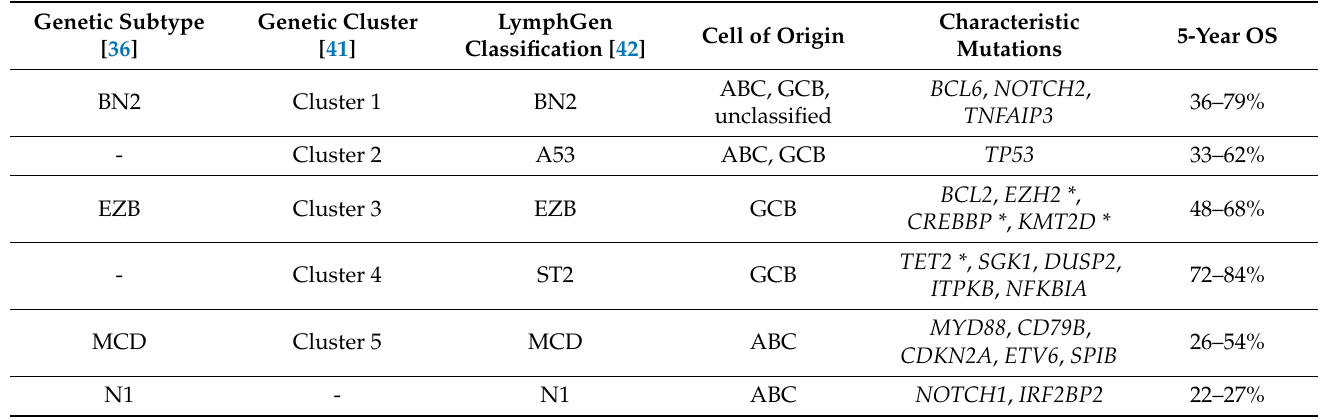
Table 1. Corresponding Diffuse Large B-cell Lymphoma subtypes based on genetic mutations * Epigenetic regulatory